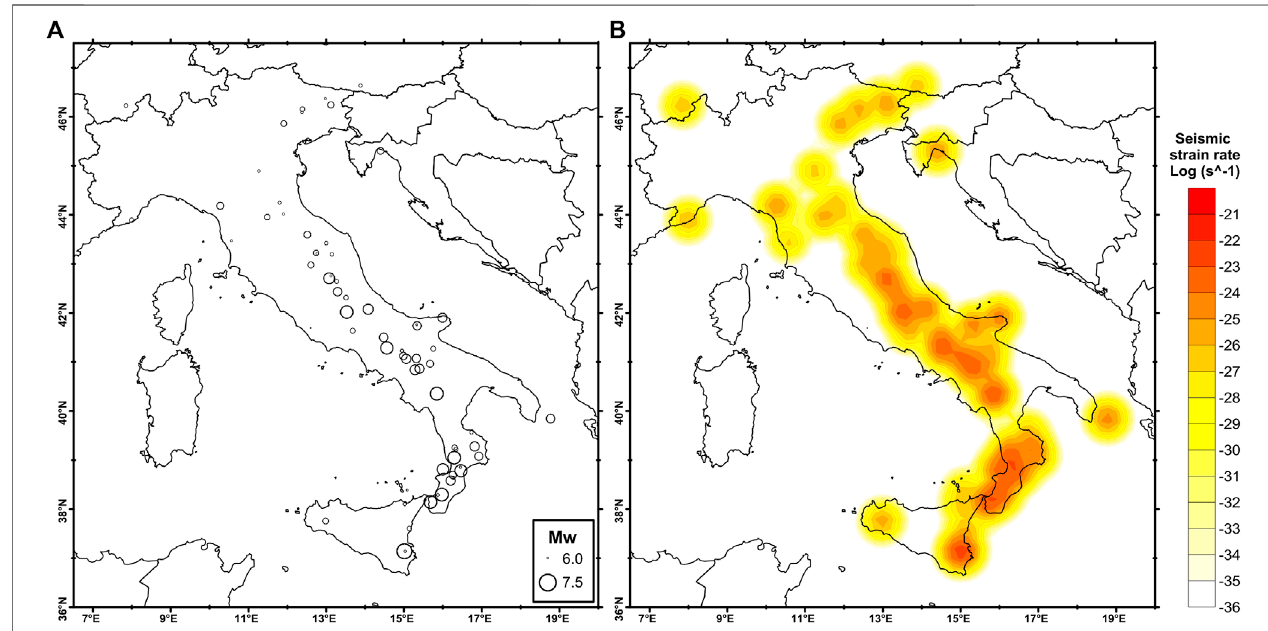
FIGURE 3 | Panel (A) shows the epicentral map of the earthquakes of magnitude over 6.0 which occurred in Italy since 1600 (CPTI15; Rovida et al., 2019; Rovida etal.,2020).Thecorrespondingspatialdistributionofseismicstrainisdisplayedinpanel (B) .Thevaluesofseismicstrainratehavebeenestimatedona0.2 ° × 0.2 ° gridby using the approach proposed by Jimenez-Munt et al.